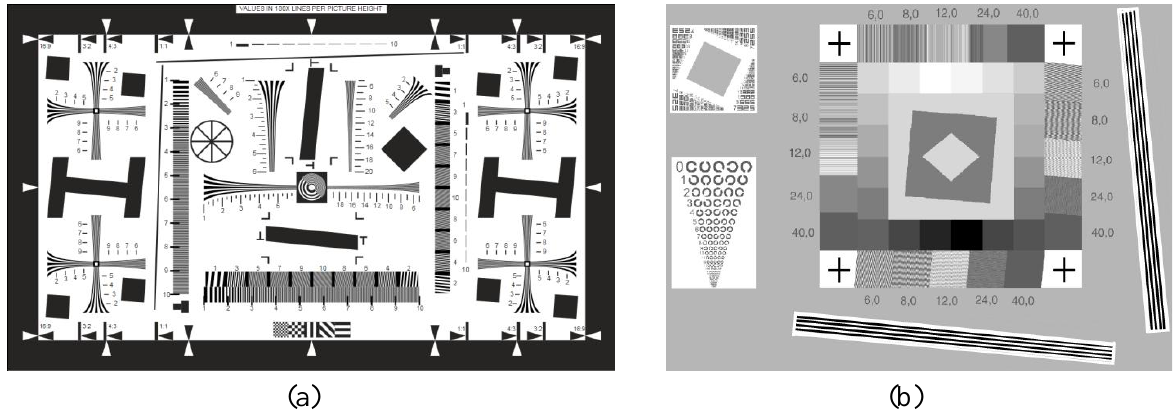
Figure 1. Standard targets for 2D imaging equipment characterization: (a) ISO12233 target for directly measuring horizontal, vertical and oblique resolution of a digital camera and frequency domain analysis; (b) ISO 16067 target for measuring spatial resolution of a 2D scanner for reflective